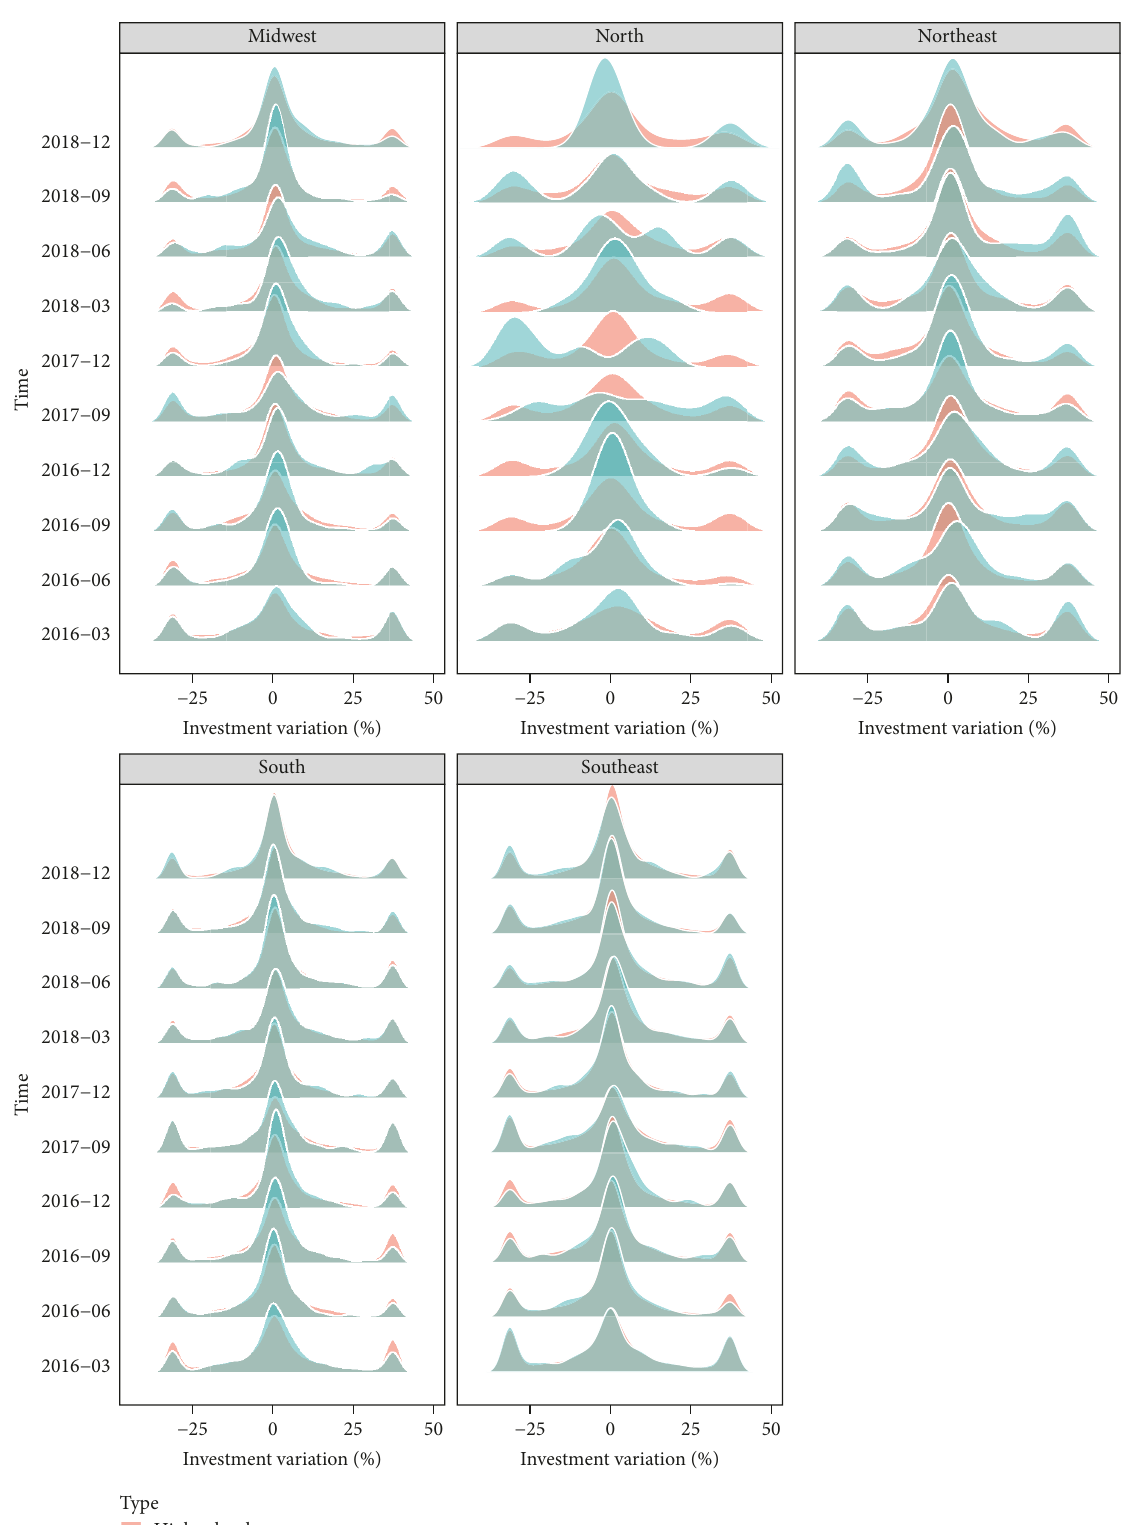
Figure 4: Distribution of investment variation across different Brazilian states (Midwest, North, Northeast, South, and Southeast) broken down by investor’s education (higher education or high school). Due to the existence of some large absolute values and to improve readability, we winsorize the investment variation distribution by 5% at each